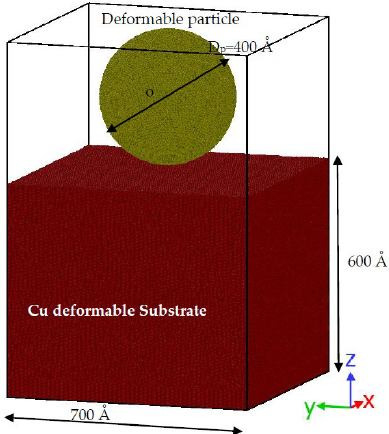
Figure 1. Cold gas dynamic spray MD simulation model.